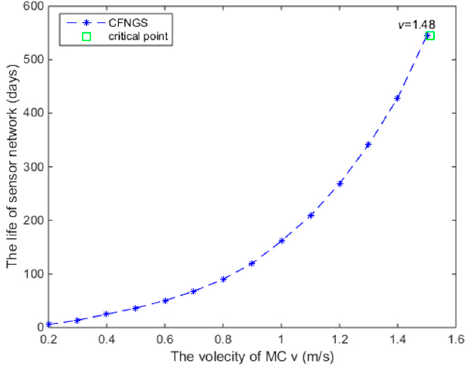
Figure 6. Lifetime of the subnetwork as a function of v.